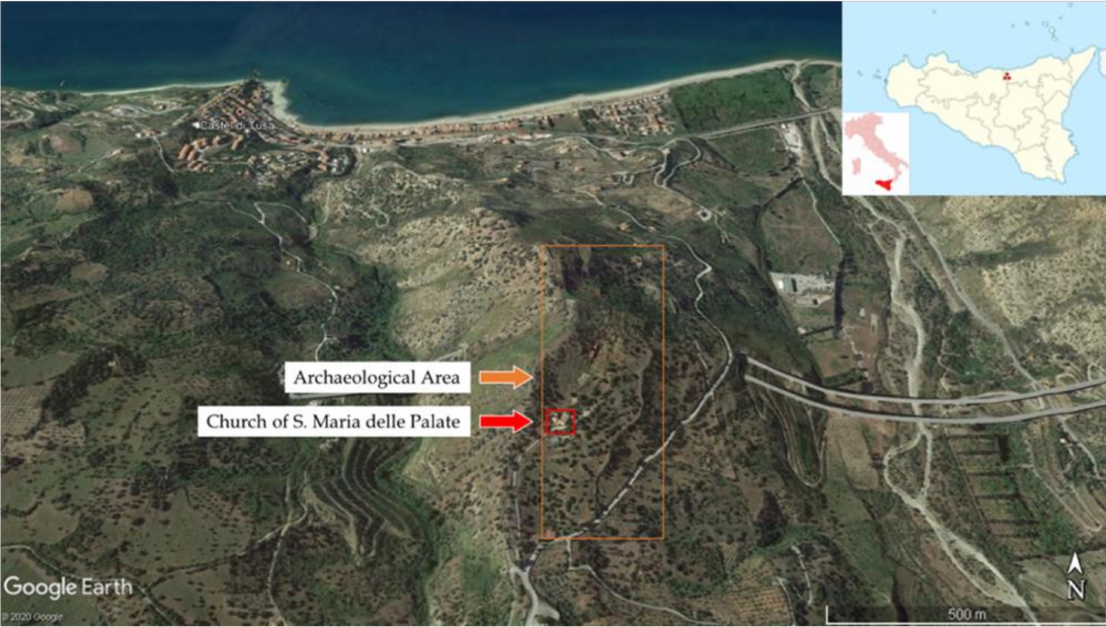
Figure 1. Location of the hill of Tusa (Messina, Sicily, Italy) on Google Earth satellite image: the orange rectangle borders the area of the archaeological site; the red square localize the church of St. Maria delle Palate, which stands on the southern side of the